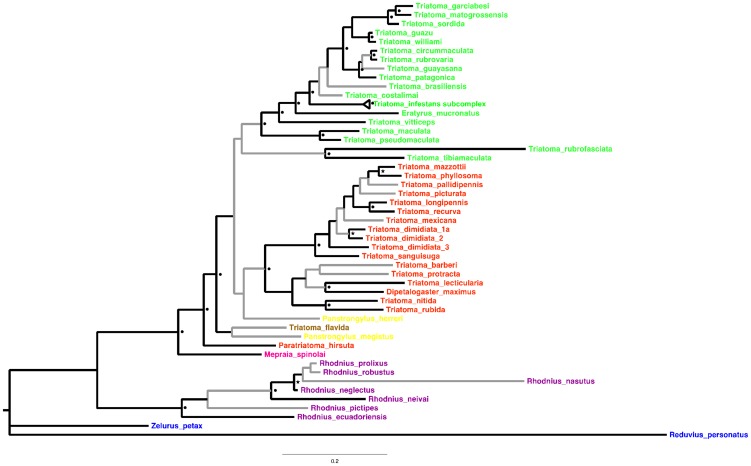
Bayesian phylogram derived from a multilocus analysis of the Triatominae subfamily, includes Zelurus petax and Reduvius personatus from the Reduviinae as outgroup (in blue).The geographic range for all species modeled in the genus Triatoma is also shown (NCA species are shown in red, South American species in green and from the Antilles in brown). Panstrongylus species are shown in yellow, Mepraia in pink and Rhodnius species are in purple. Branch color indicates PP<0.8 in gray and ≥0.8 in black. Black circles indicate PP≥0.95<; black stars PP≥0.9<0.95.